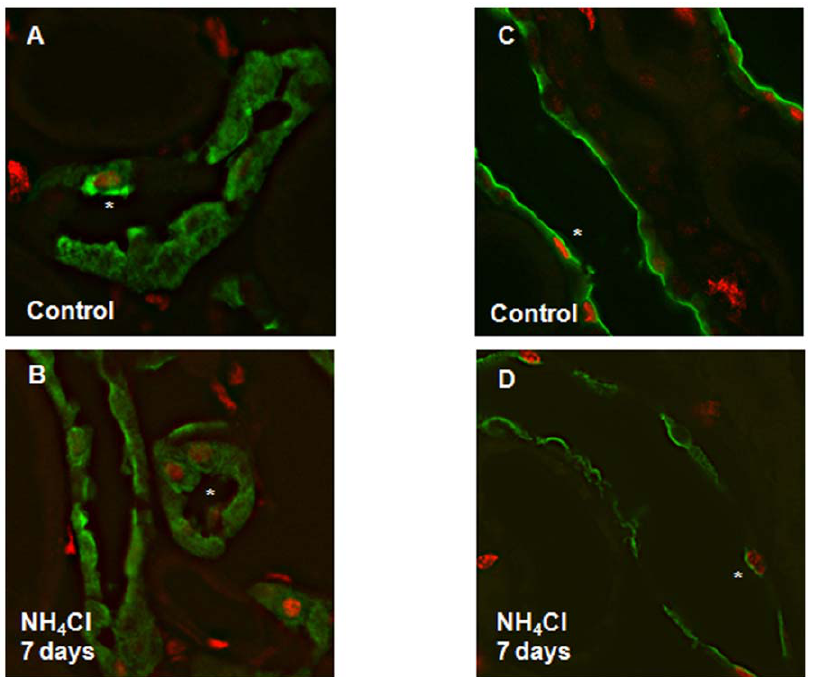
Figure 1. Proliferation of segment-specific cells after 7 days of acidosis in the CCD and OMCD. Animals were treated for 7 days with NH 4 Cl or were left untreated (controls). ( A,B ) Labelling of segment specific cells in the CCD with antibodies against calbindin D28K (green) in the CCD under control conditions and after 7 days of acidosis: PCNA staining (asterisk) was observed in calbindin D28k positive cells under control conditions and after 7 days of NH 4 Cl. ( C,D ) Segment-specific cells in the OMCD were identified by staining of AQP2 (green). Similarly to the CCD, some OMCD principal cells were positive for PCNA (asterisk) under control and acidotic